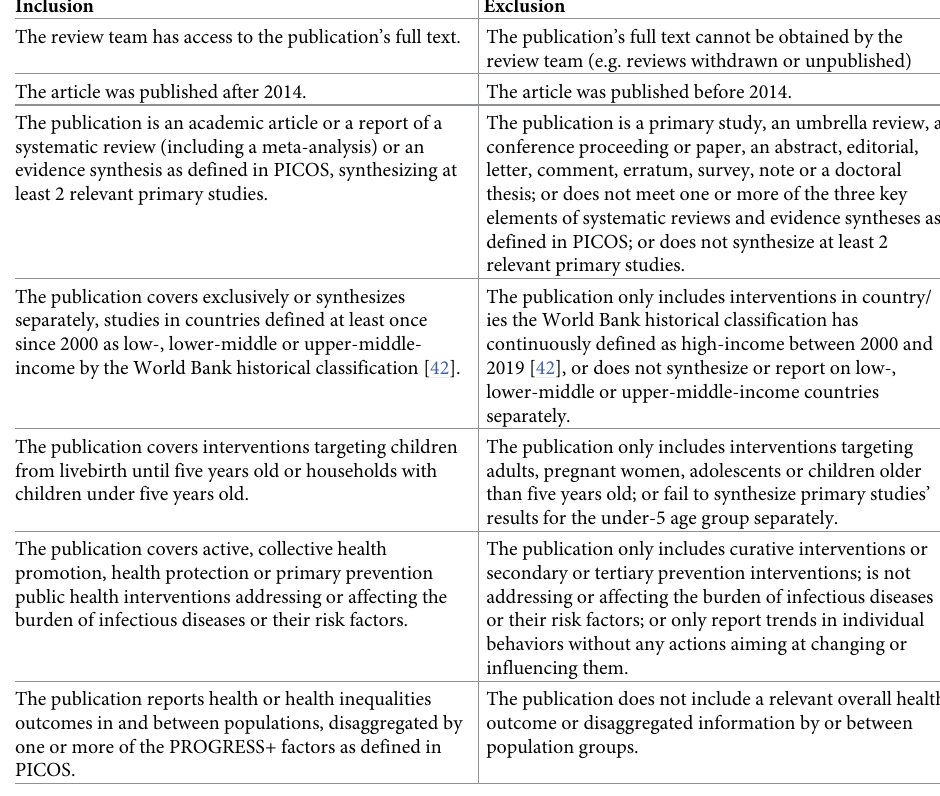
Table 1. Inclusion/exclusion